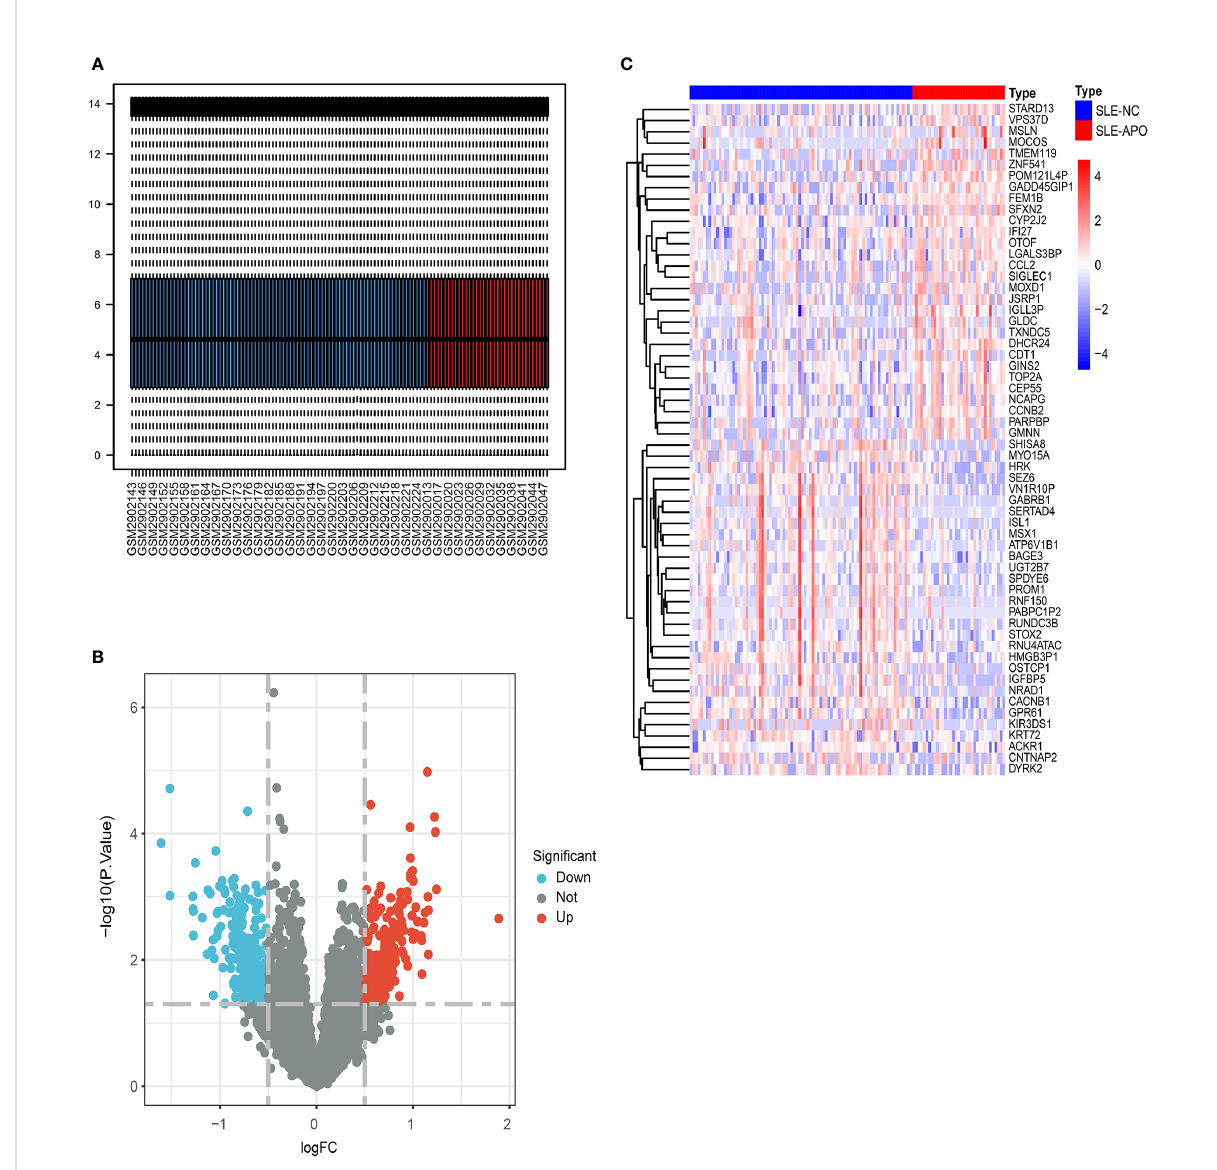
FIGURE 2 The screening of DEGs from GSE108497. (A) Visualization of GSE108497 after normalization. The horizontal axis represents the sample symbol and the vertical axis represents the expression values. The short black line in the box plot indicates the median value of gene expression. (B) A volcano plot of differentially expressed genes (DEGs). The genes with an absolute log2 fold change greater than 0.5 and P -value less than 0.05 were selected. Red dots represent upregulated genes while blue dots represent downregulated genes. (C) Heat map of the DEGs. The legend of “ type ” on the top right indicates the SLE patients with APO (SLE-APO) and SLE patients with normal pregnancy outcome